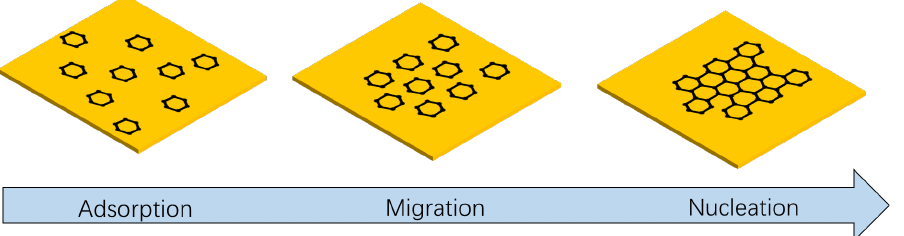
Figure 4. Surface reaction of graphene growth from benzene at low temperatures (300~600 °C).